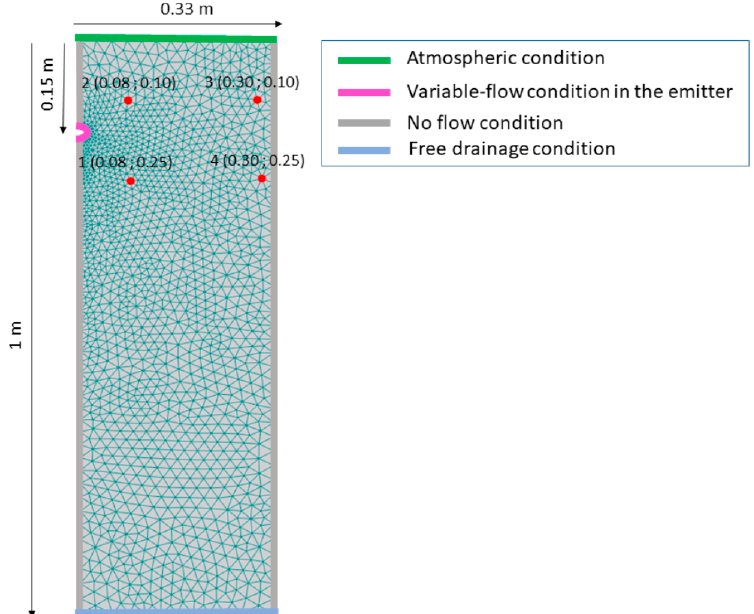
Figure 1. Flow domain, positions of soil water sensors (1, 2, 3, and 4), and boundary conditions. Values into brackets show horizontal distance in meters from the dripline and depth of the points, where soil water content was monitored.